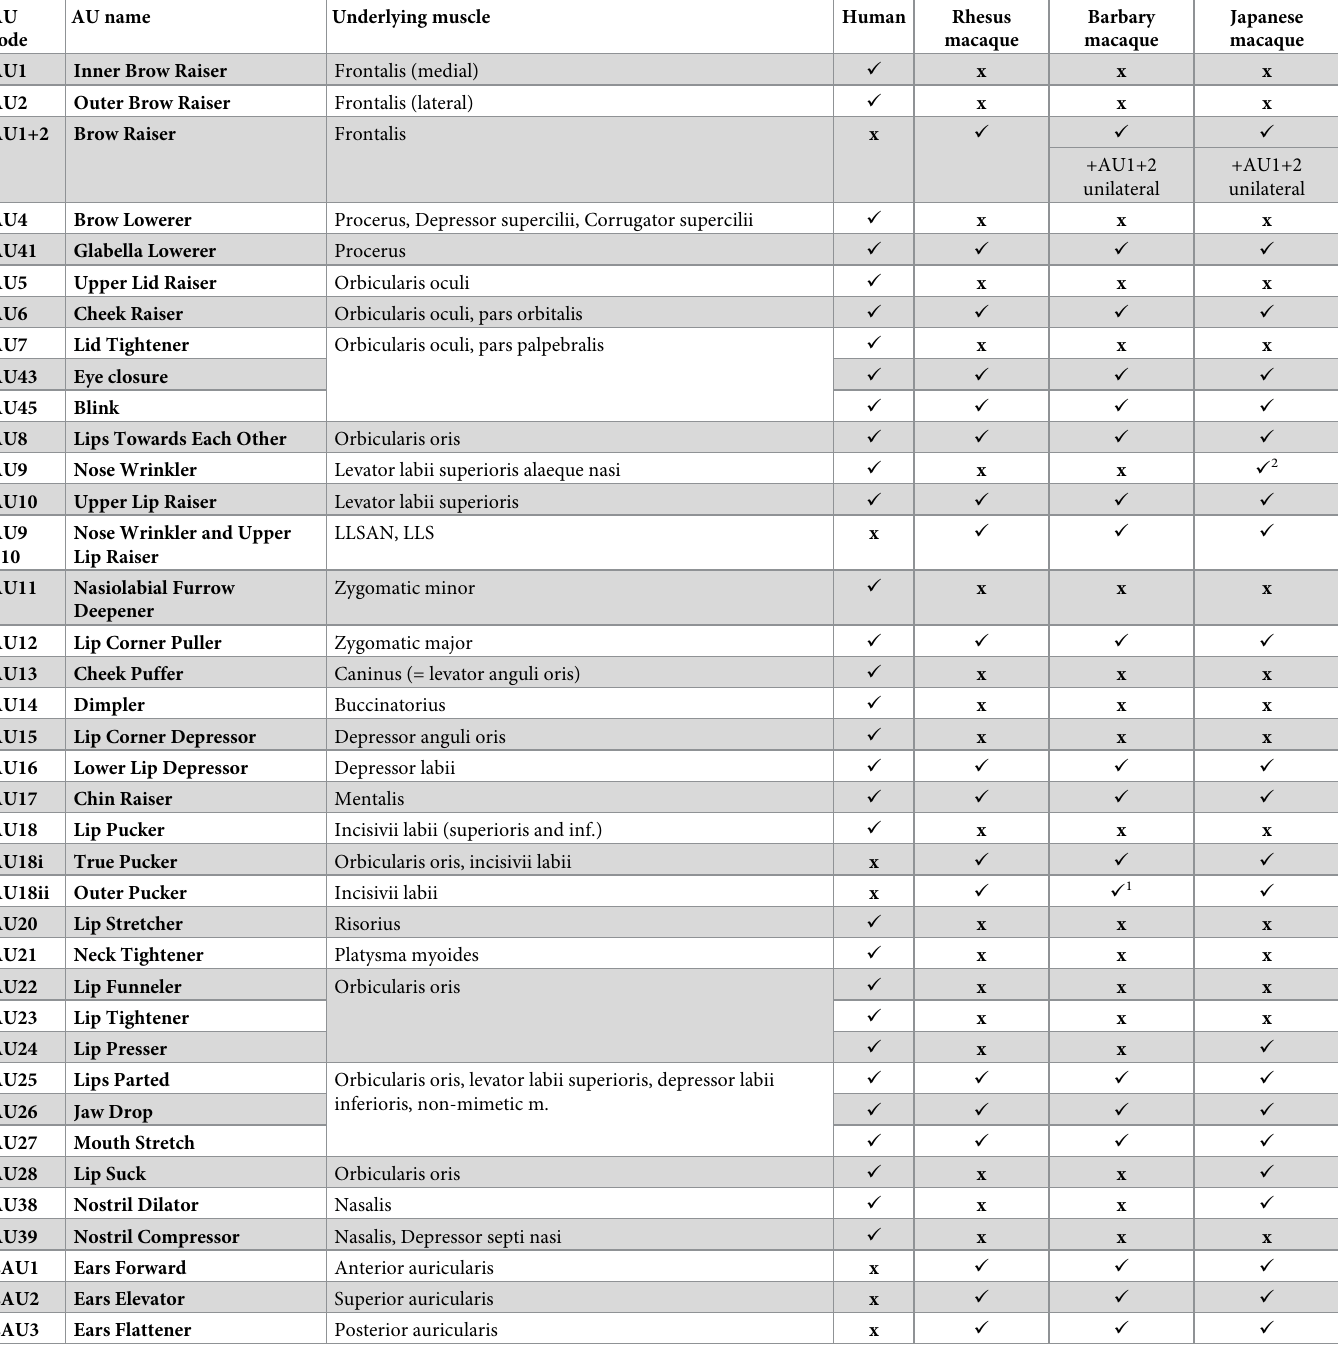
Table 2. Comparison between the Action Units (AUs) and Ear Action Units (EAUs) previously included in the FACS for humans [67], rhesus macaques [14], and Barbary macaques [15] with what we identified here for Japanese macaques. AU